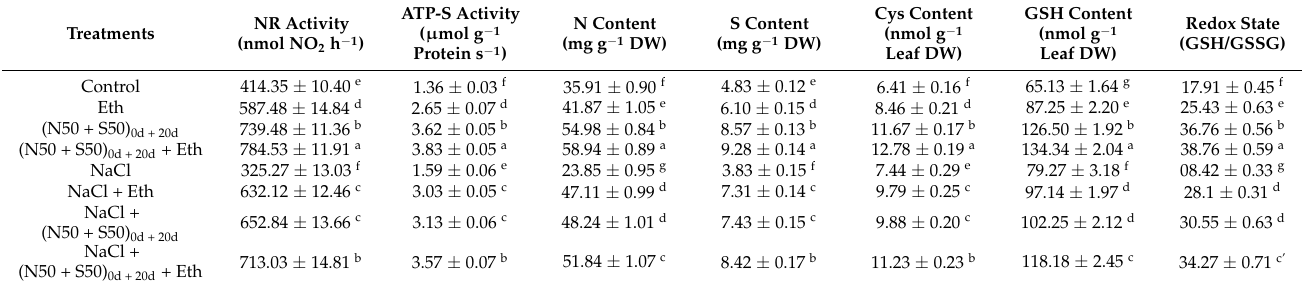
Table 3. Activity of nitrate reductase (NR) and ATP-sulfurylase (ATP-S), content of nitrogen (N) and sulfur (S), cysteine (Cys), reduced glutathione (GSH), and redox state in mustard plants at 40 DAS. Plants were raised with split dosage of N and S (50 + 50 mg kg − 1 soil) at sowing time (0 DAS) and at 20 DAS, and treated with 200 µ L L − 1 ethephon (Eth) in the absence or presence of 100 mM NaCl. Values are presented as means ± SE ( n = 4). Data followed by the same letter are not significantly different by LSD test at p < 0.05. DAS: days after sowing; DW: dry weight.